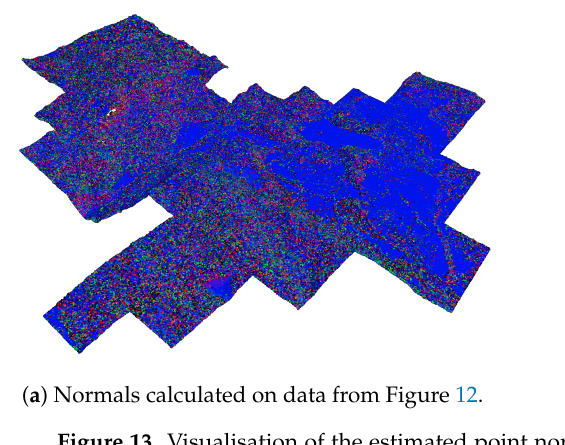
Figure 13. Visualisation of the estimated point normals. x , y , and z components are mapped to red, green, and blue colours, respectively. The colours in the images show the estimated orientation of surfaces on which the points are (e.g., a green point represents a surface whose normal points along the y